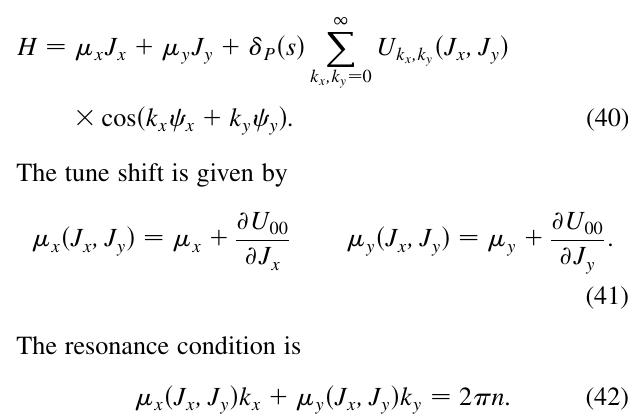
FIG. 13. (Color) Evolution of p and p of ten sampled particles (cid:11) r (cid:5) 0 : 285 , (cid:8) (cid:5) 0 : 295 , and (cid:12) (cid:5) 0 : 27 . Each trajectory is for (cid:8) x y plotted in both plots with the same color.